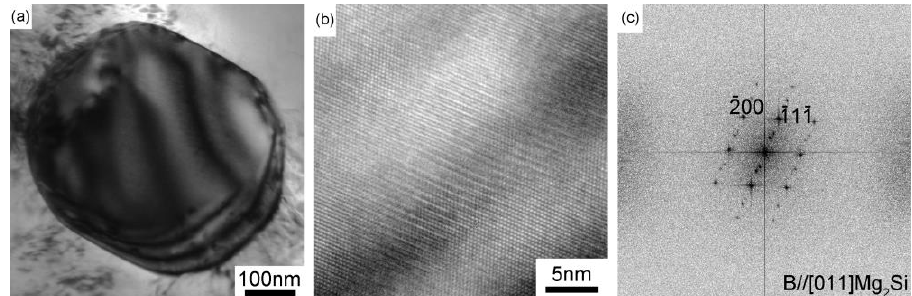
Figure 13. ( a ) Bright field TEM image, ( b ) HRTEM image and ( c ) the fast Fourier transform (FFT) of the plate-shaped Mg 2 Si phase. No Ca-rich layer was observed along the plate-shaped Mg 2 Si in the [011] Mg2Si zone axis within the resolution in the present investigation.